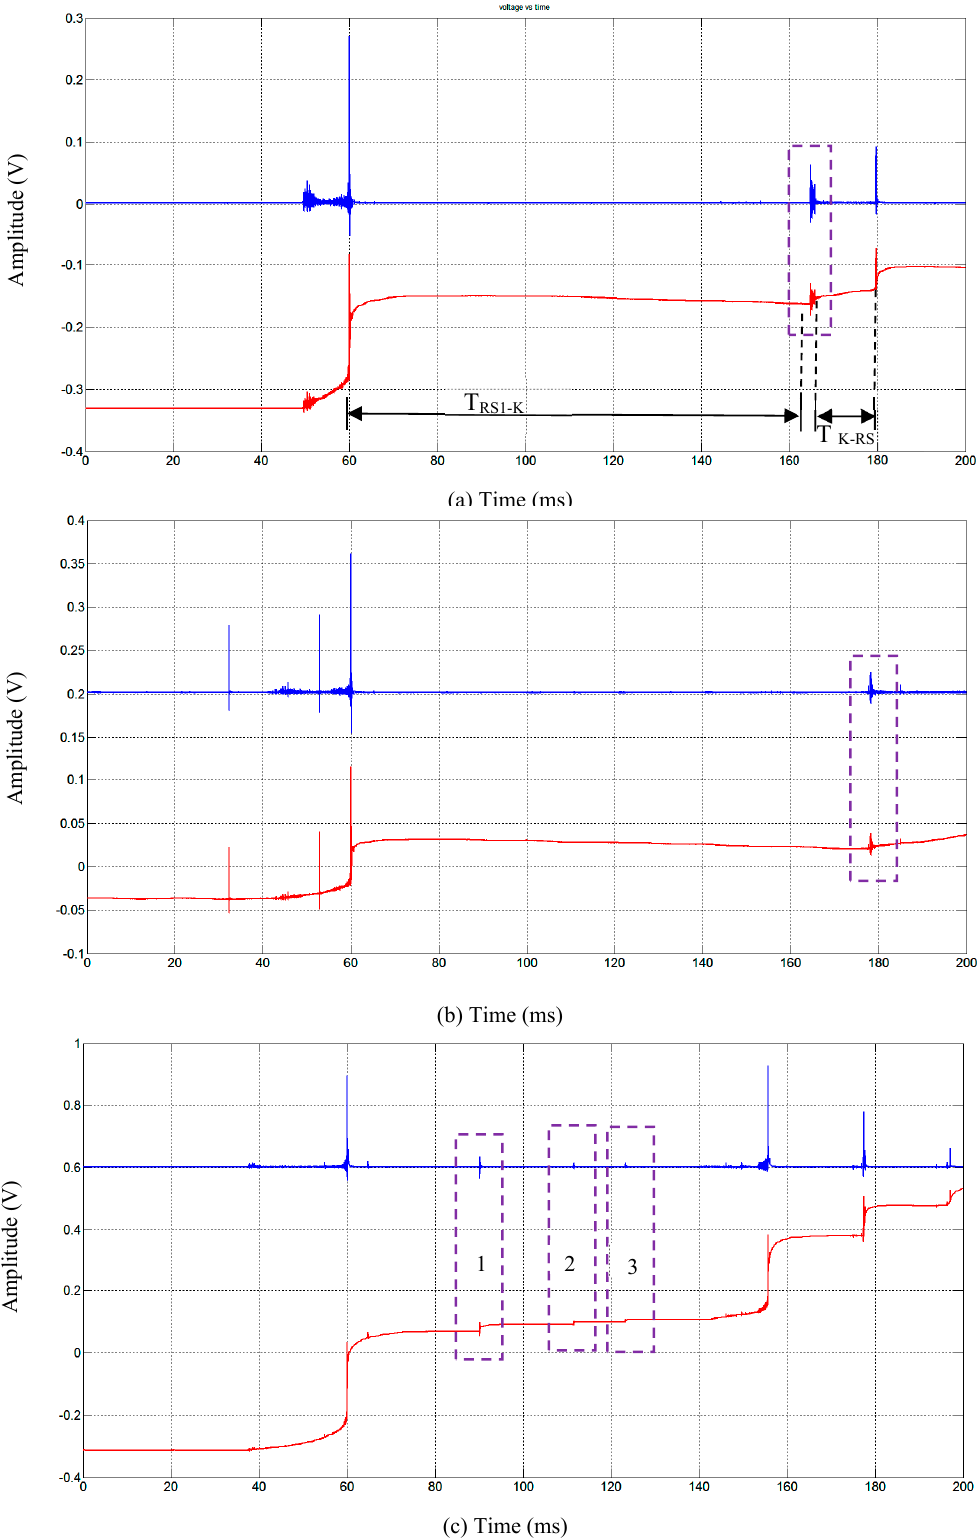
Figure 2. ( a ) Isolated K-change between two return strokes, ( b ) Isolated K-change occurred after the last return stroke captured inside the recording time window, and ( c ) Three consecutive K-changes. Electric fields recorded using fast and slow antenna systems are presented in blue and red colors. Measured parameters of T RS1-K and T K-RS are presented in ( a ) above. Data were recorded on 4/3/2013 19:53:00. UTC.